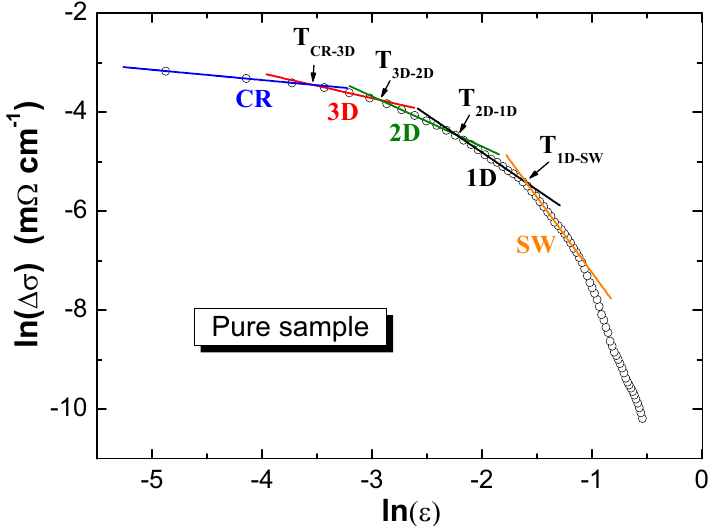
Figure 6. Analysis of the fluctuation-induced conductivity for the pure FeSe sample, using a plot of ln ( ∆ σ ) vs. ln (cid:101) . Note the five fluctuation regimes shortwave (SW) ( ), 1D ( ), 2D ( ), 3D ( ), and critical region (CR) ( ) being